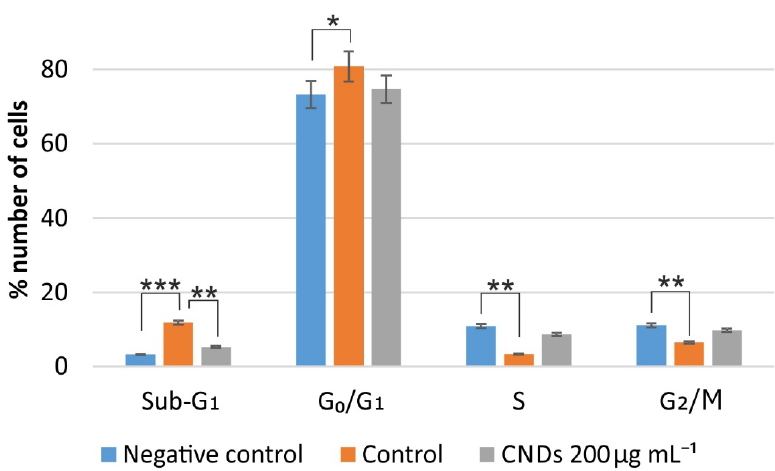
Figure 9. % number of cells in the four phases of cell cycle; negative control: cells not irradiated, control cells: irradiated cells, without CNDs-DS treatment, sample: cells pre-treated with 200 μg mL −1 CNDs-DS; * denotes statistically significant differences at p < 0.05, ** at p < 0.01 and *** at p < 0.001